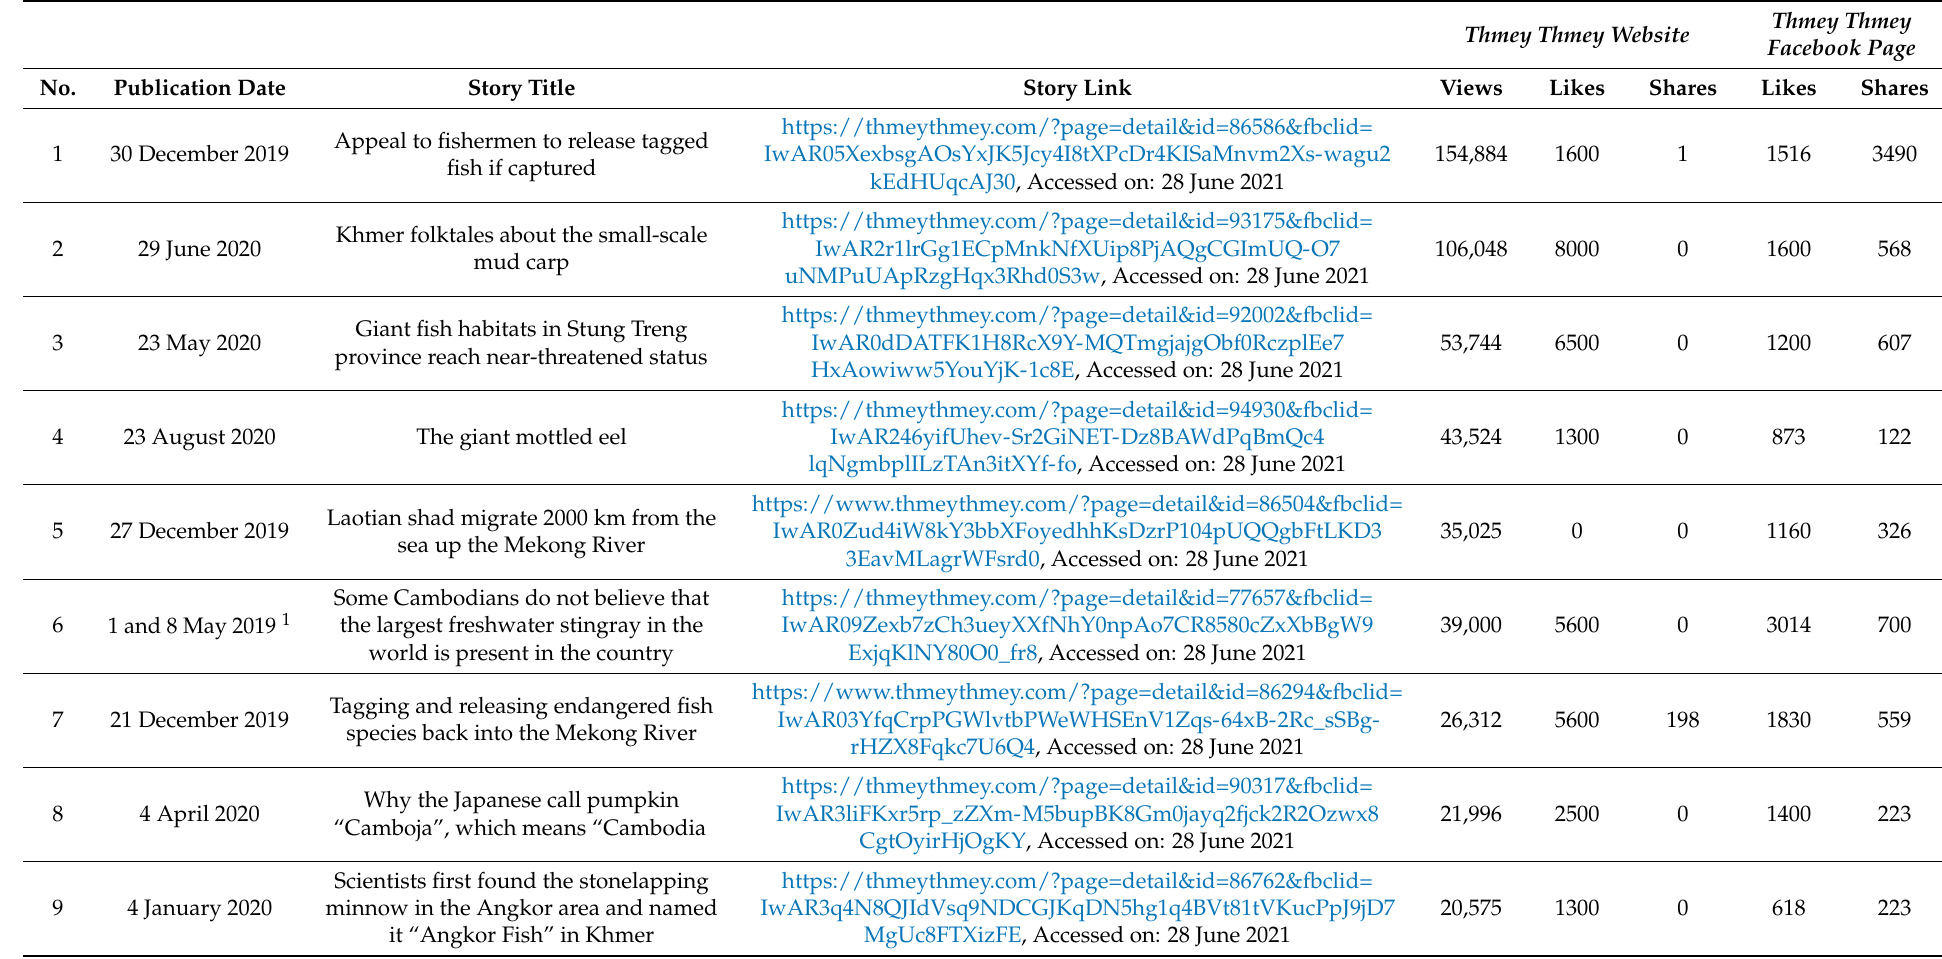
Table 3. Engagement metrics of the 20 most viewed WOM Stories on Thmey